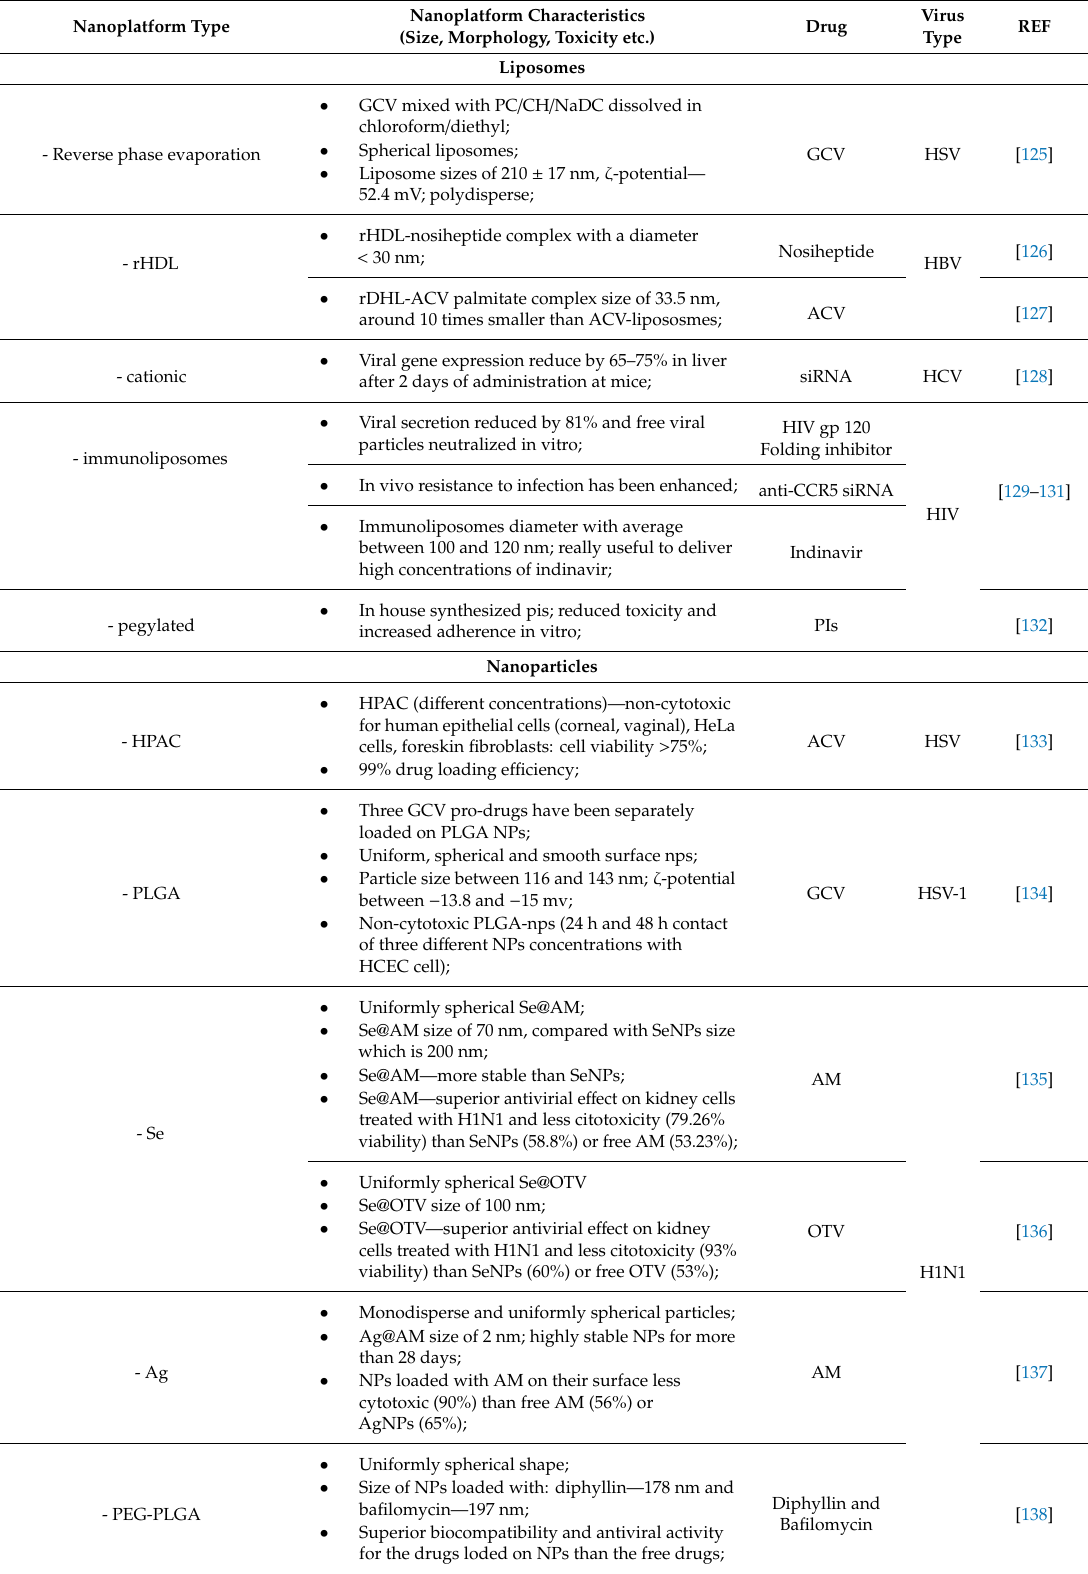
Table 2. Nano-delivery systems developed for antiviral drugs. Nanoplatform